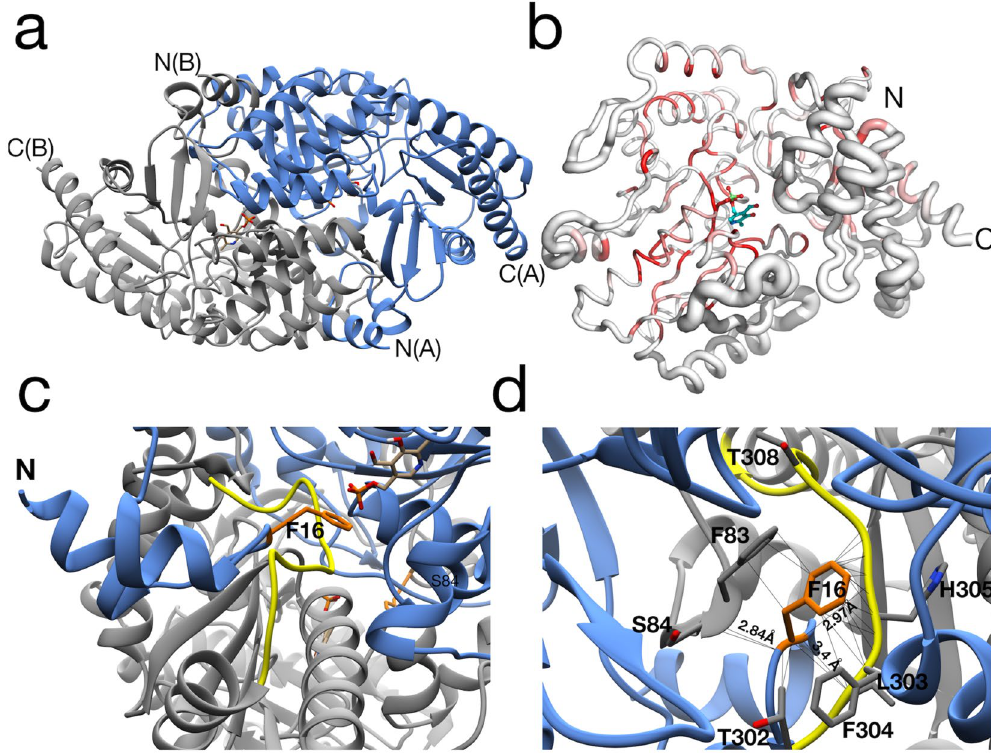
Figure 5. The Vb TA T16F dimer. ( a ) Quaternary organisation of Vb TA T16F, showing chains A (blue) and B (grey). The N- and C-termini are indicated and PLP is shown in sticks; ( b ) Secondary structure of Vb TA T16F shown in sausage representation, as automatically generated by ENDscript 2.0 (http://endscript.ibcp.fr) 29 . Structure conservation with 125 structure homologs deposited in the PDB is indicated by ribbon thickness, with regions of low conservation being thicker than highly conserved regions (thin regions). Sequence identity is indicated by red coloring; the redder the residue, the more conserved it is. The N- and C-termini are indicated and PLP is shown in sticks; ( c ) the F16 mutation (orange sticks) and bound PLP (sticks, atom colouring) in chain A are highlighted. The active site loop region (residues 298–313) in chain B, located between α 11 and α 12 is shown in yellow, and d) Detailed view of the interaction network ( < 4 Å; grey lines) between F16 (orange sticks) and residues F83, S84 and 302–305 (grey sticks) of the opposing monomer. The active site loop region (residues 298–313) in chain B is coloured yellow. Bond distances (Å) for the three hydrogen bonds are indicated. Panels A, C and D were generated using Chimera 32 , whereas panel B was generated using MacPymol 2.0.6.